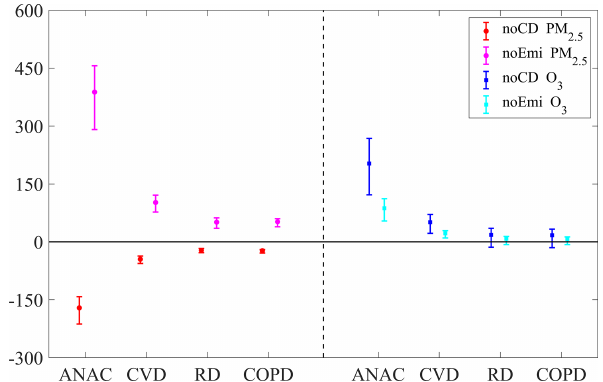
Figure 13. Differences in premature mortality from ANACs, CVDs, RDs and COPDs due to PM 2 . 5 (left of the dotted line) and O 3 (right of the dotted line) between the baseline and sensitivity simulations. The dots represent the mean estimate, and the whiskers represent